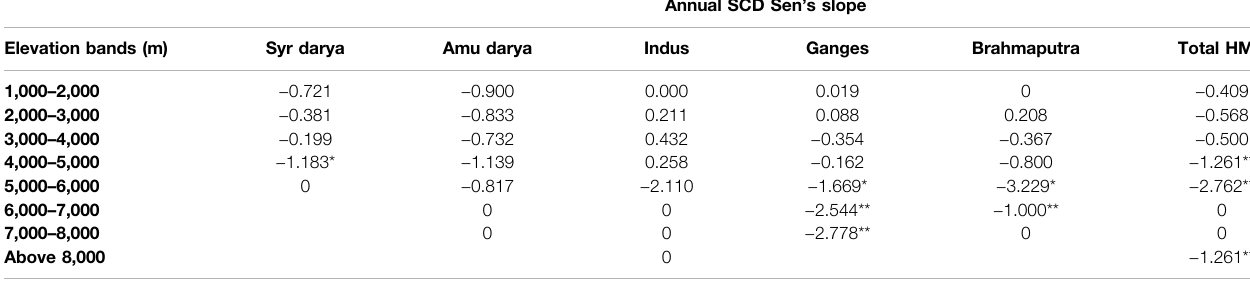
Annual SCD Sen ’ s slope